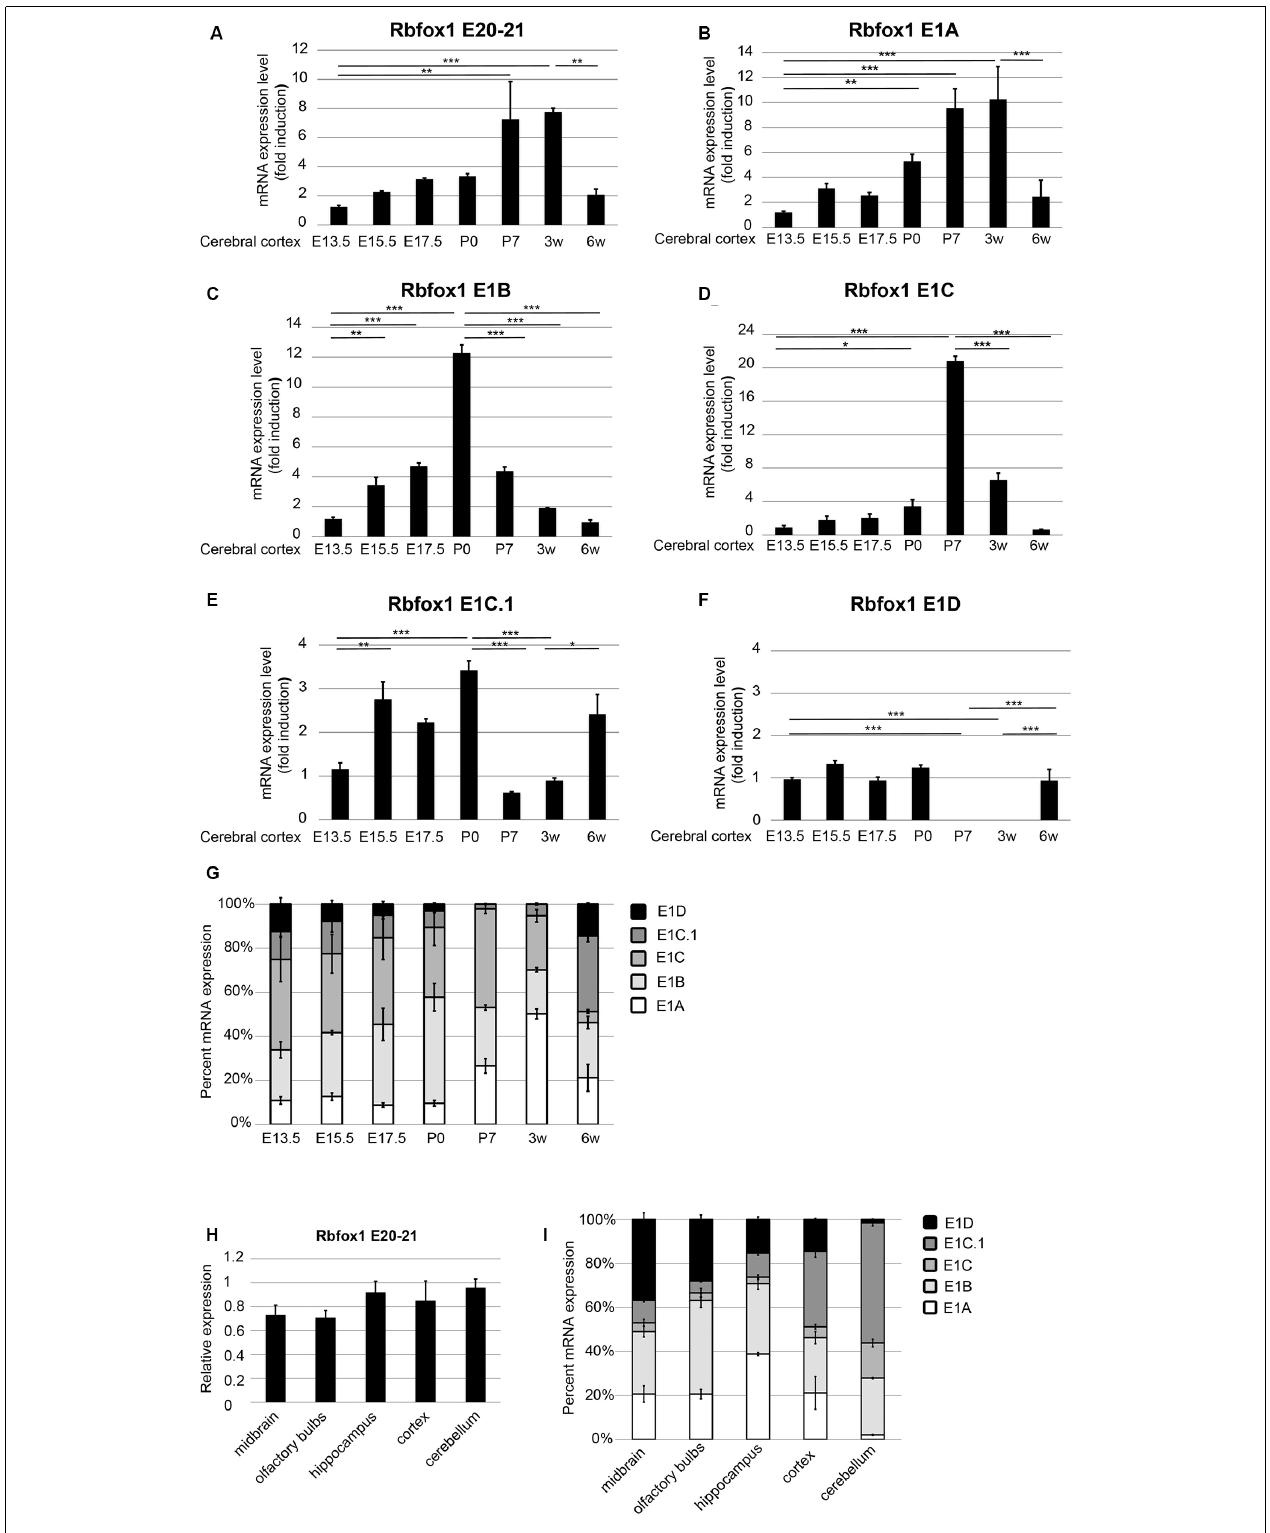
FIGURE 3 | Expression of the Rbfox1 alternative first exons during embryonic and postnatal development of the cerebral cortex and in different brain subregions. (A–F,H) RT-qPCR with primers corresponding to Rbfox1 exons 20/21 or the alternative first exons. Total RNA was isolated from the cerebral cortex at different